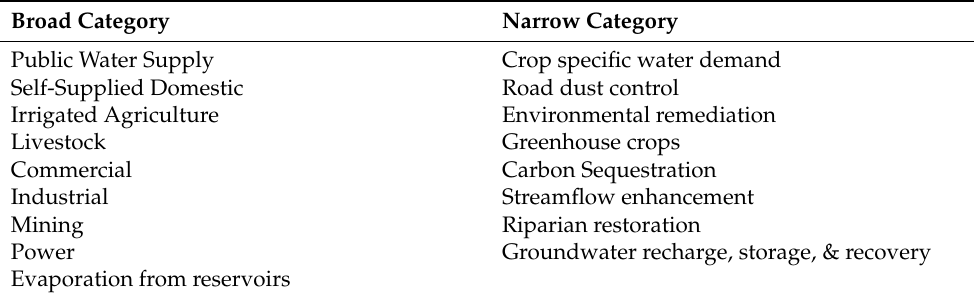
Table 2. Potential uses of treated PW, assuming no regulatory or treatment